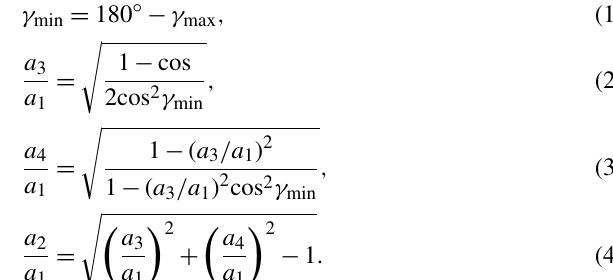
Fig. 1: the length of the curved beam) is taken as L v = 320mm